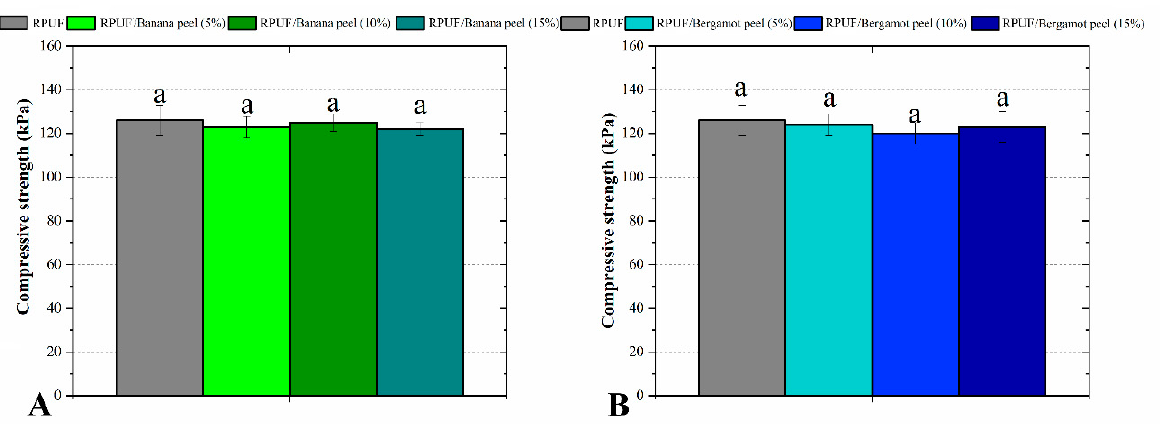
Figure 7. Compressive properties of the studied RPUF with Banana peels ( A ) and Bergamot peels ( B ). RPUF is the neat rigid polyurethane foam and filler type, and filler content is the numbers after the bars and between parentheses, respectively. Different letters represent statistically different means.